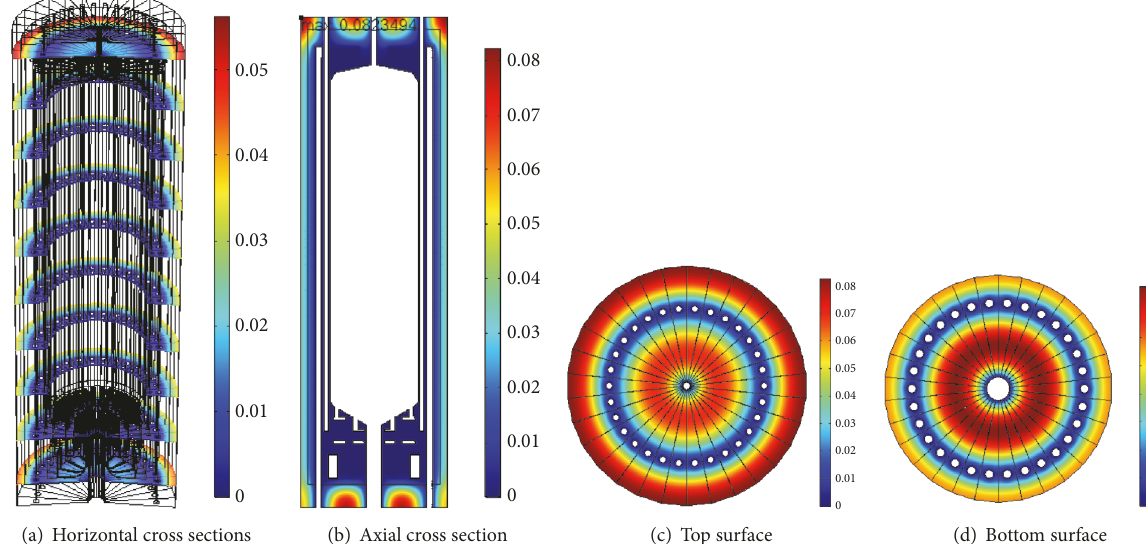
Figure 3: Distribution of 𝐶 𝑟 (%) in HTR-PM core ( t = 50 d).